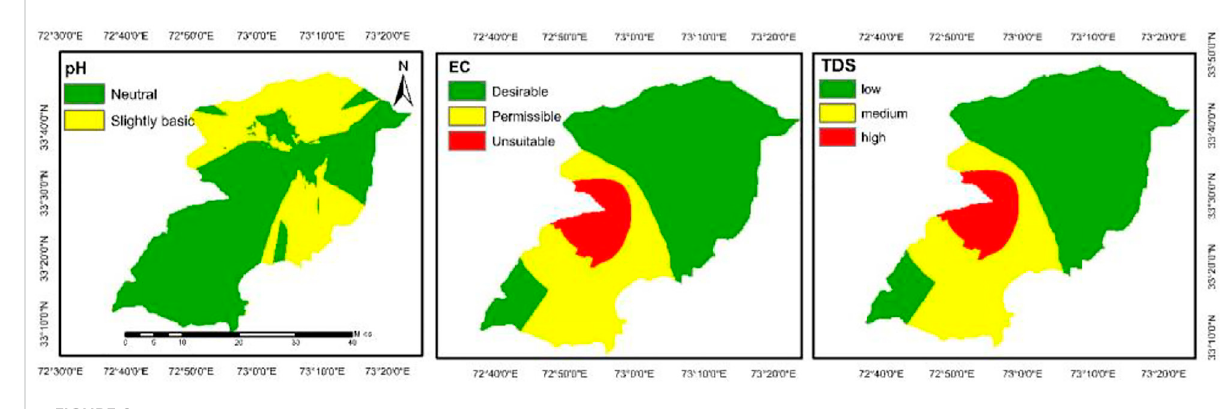
FIGURE 2 Spatial distribution of pH, EC, and TDS in the groundwater of Rawalpindi and Islamabad.